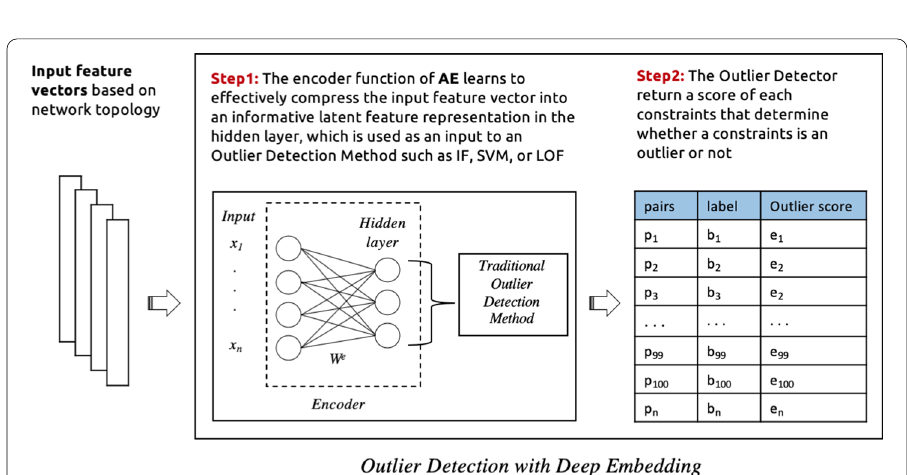
Fig. 4 An illustration of the process for identifying noisy pairwise constraints using outlier detection via deep embedding